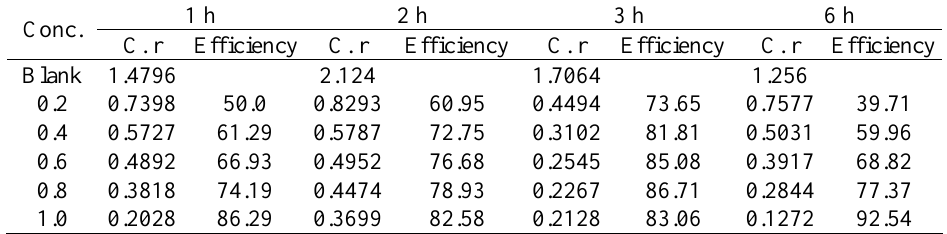
as the function of exposure 3 using Azadirachta indica seed extract 3